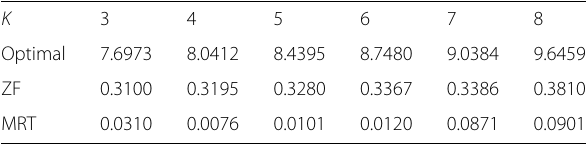
information versus the number of antennas at the BS, which is set to be equal to the number of users in all sim- ulations. The capacity of unicasting rate is also showed simultaneously under ideal conditions without the inter- ception of